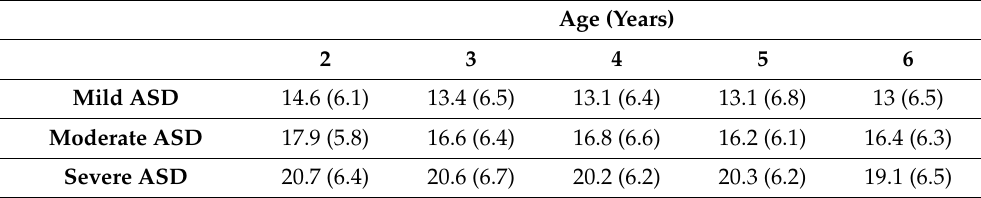
Table 5. Averaged Sensory Awareness (assessed by ATEC subscale 3) score for the mild, moderate, and severe ASD groups. A lower score indicates symptom improvement. The data are presented as the mean (SD).